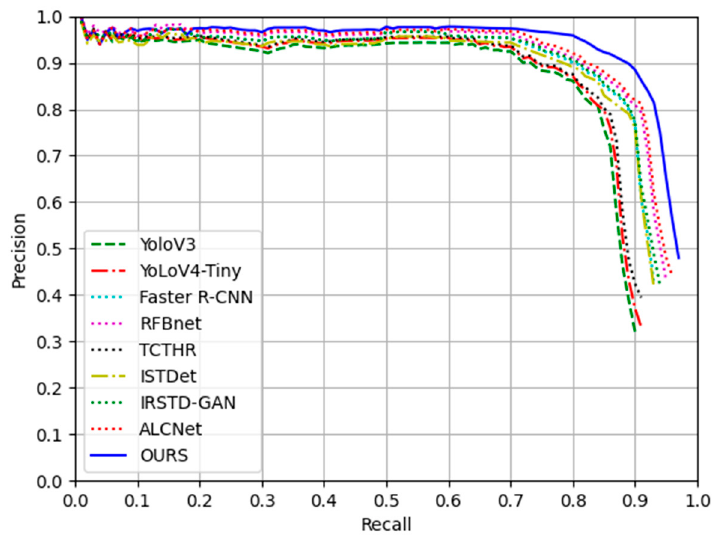
Figure 13. Comparison results of P–R curves of the nine state-of-the-art methods over the